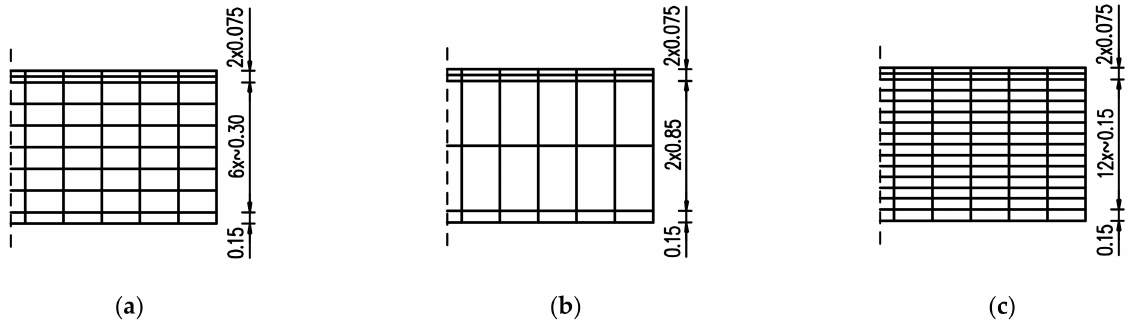
Figure 6. The height of finite elements at the thickness of 2 m slab: ( a ) based on Figure 4b—validation case, ( b ) coarse mesh, ( c ) dense mesh.